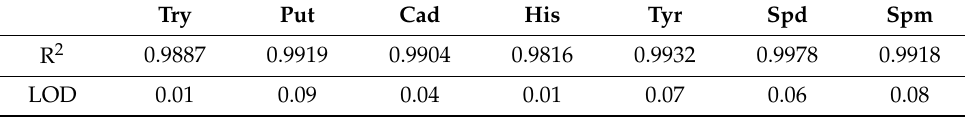
Table 4. R 2 and LOD values of the validated HPLC method for biogenic amines in wheat germ extracts.